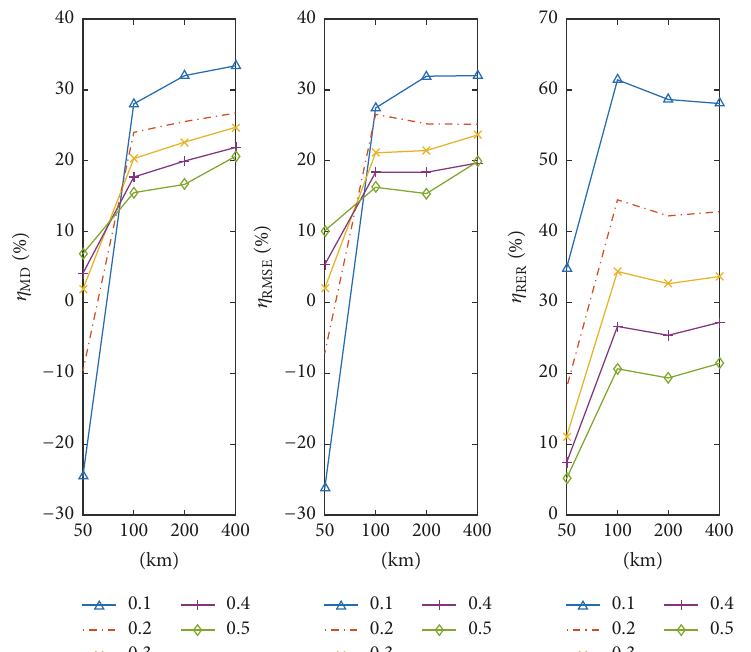
Figure 8: The same as Figure 7, but for CWP constraint.